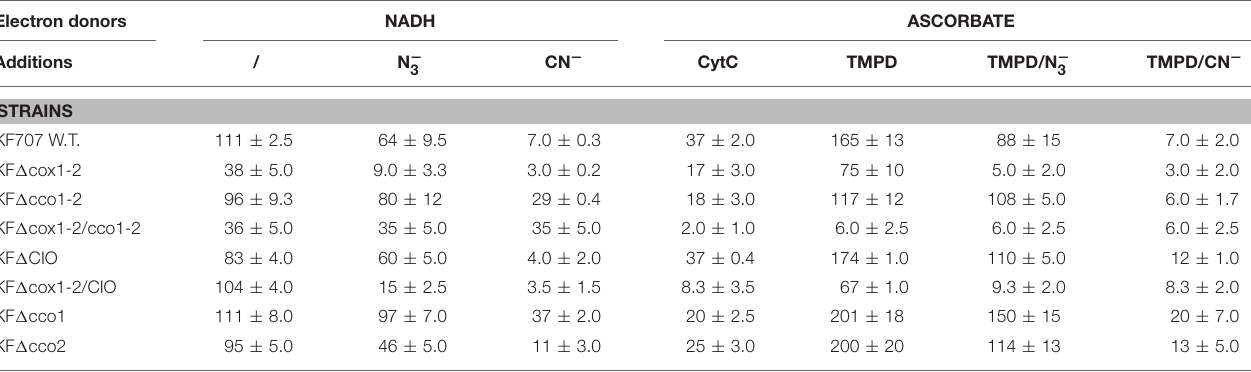
TABLE 4 | Respiratory activities in membranes from KF707 W.T. and oxidase mutant cells grown, until the stationary phase (OD 600 nm ) 0.7–0.9, in biphenyl (Bp) as sole carbon source. Electron donors NADH ASCORBATE